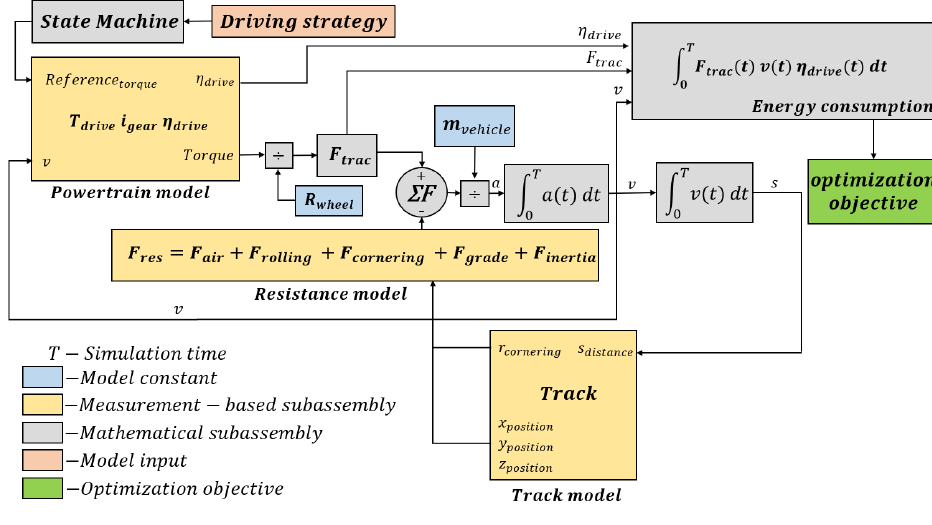
Figure 2. Overview of the vehicle model [16].